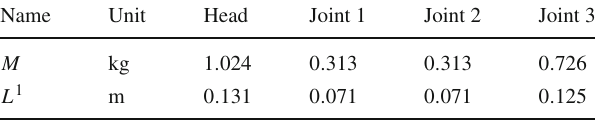
Table2 Thedetailedparametersofeachsegmentinbiomimeticrobotic fish